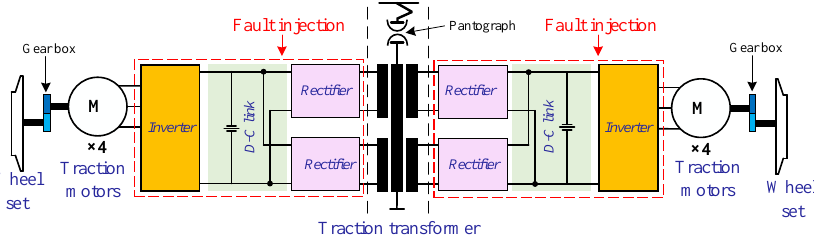
Figure 1. The schematic diagram of electrical drive systems in high-speed trains